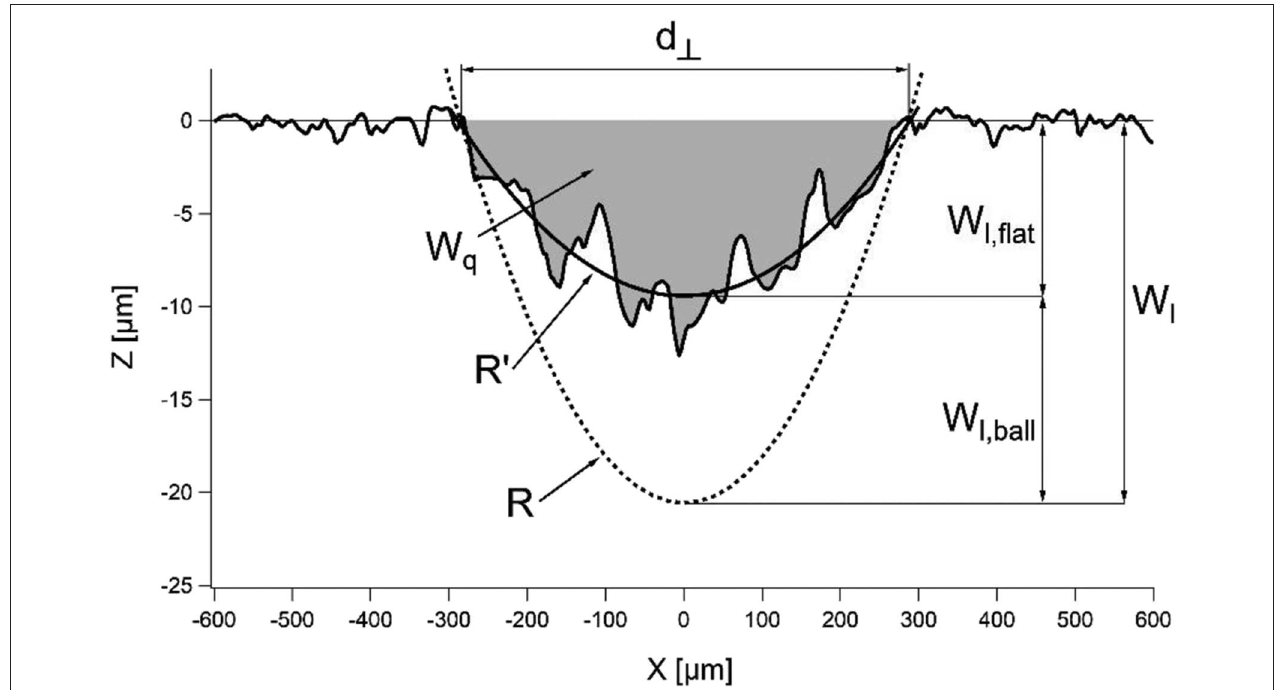
FIGURE 1 | Line profile of a wear track on a 100Cr6 plane taken from a WLI measurement. The picture shows the track width d ⊥ , the planimetric wear W q (cross-sectional area of the wear track, filled in gray), the fitted circumference with radius of curvature R ′ , the circumference with known sphere radius R , the total linear wear W l , and the linear wear of ball and plane, W l , ball and W l , flat .